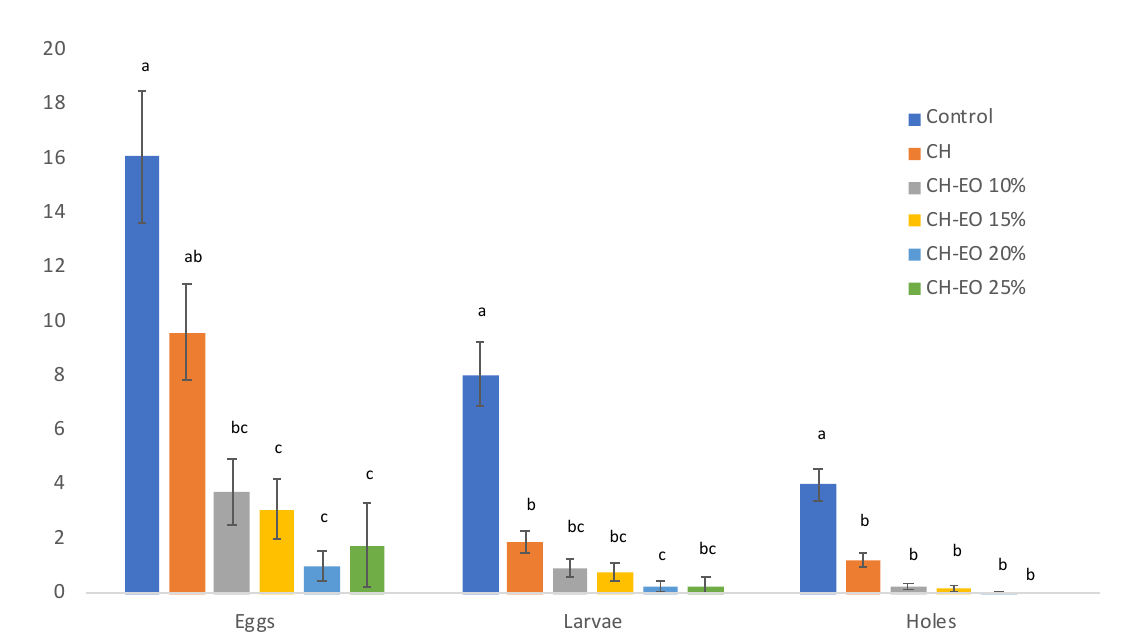
Figure 3 . In vitro protective effect of chitosan and chitosan plus Ferulago campestris essential oil (EO) against reproductive activity of females of Acanthoscelides obtectus . Histograms ( y axis) represent the mean values of eggs, larvae, and larval entrance holes. Bars represent standard error. Control, untreated beans; CH, chitosan coated beans; CH–EO beans coated with chitosan added with EO at different percentages; different letters indicate significant differences according to Dunn–Bonferroni pairwise comparisons test ( p ≤ 0.05).